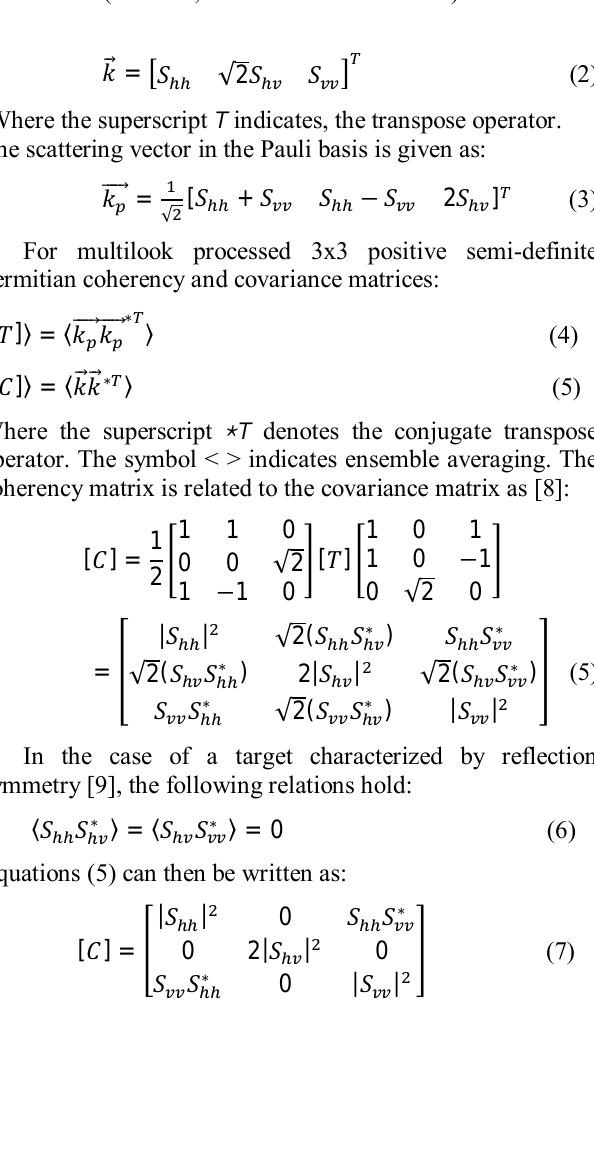
Figure 1: The RGB image of the polarimetric data of the test site (Red:HH, Green:HV and